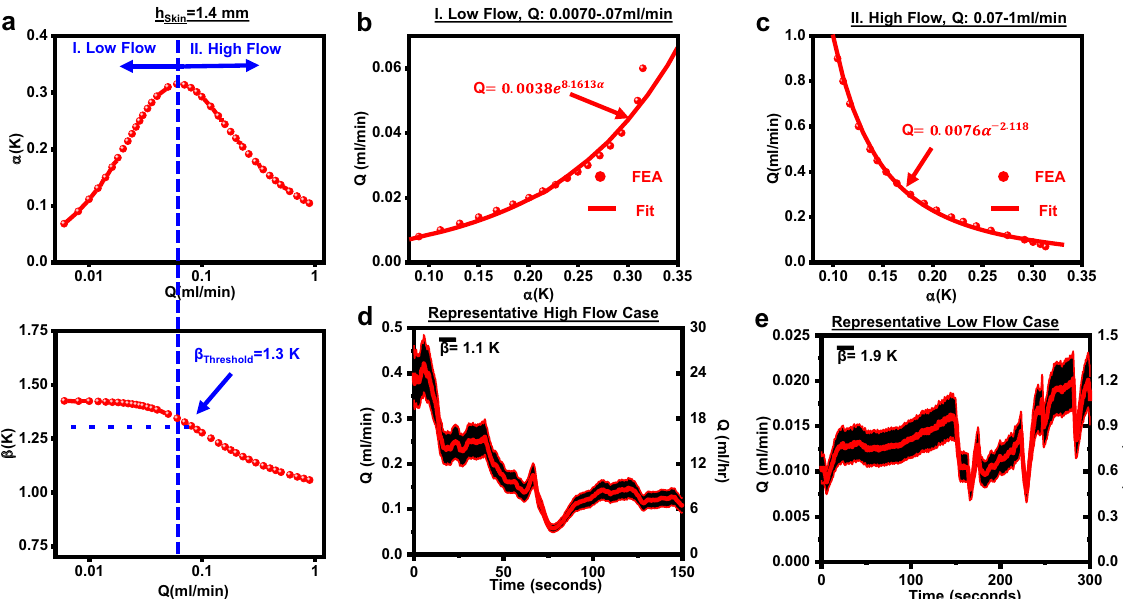
Fig. 6 Flow rate measurements on a healthy out-patient (M, 21). a FEA-simulated curves for α (Q) (top) and β (Q) (bottom) for h skin = 1.4 mm, corresponding to measured value on the out-patient, with an in fl ection point at Q = 0.07 ml/min corresponding to β = 1.3 K. b Simulated data (circles) and fi t (line, exponential curve) for low- fl ow regime corresponding to 0.007 < Q < 0.07 ml/min. c Simulated data (circles) and fi t (line, power-law curve) for high- fl ow regime corresponding to 0.07 < Q < 1 ml/min. d Representative continuous high- fl ow measurements on the out-patient with shaded regions representing uncertainty estimates (±15%). e Representative low- fl ow measurements on the out-patient with shaded regions representing uncertainty estimates (±15%).